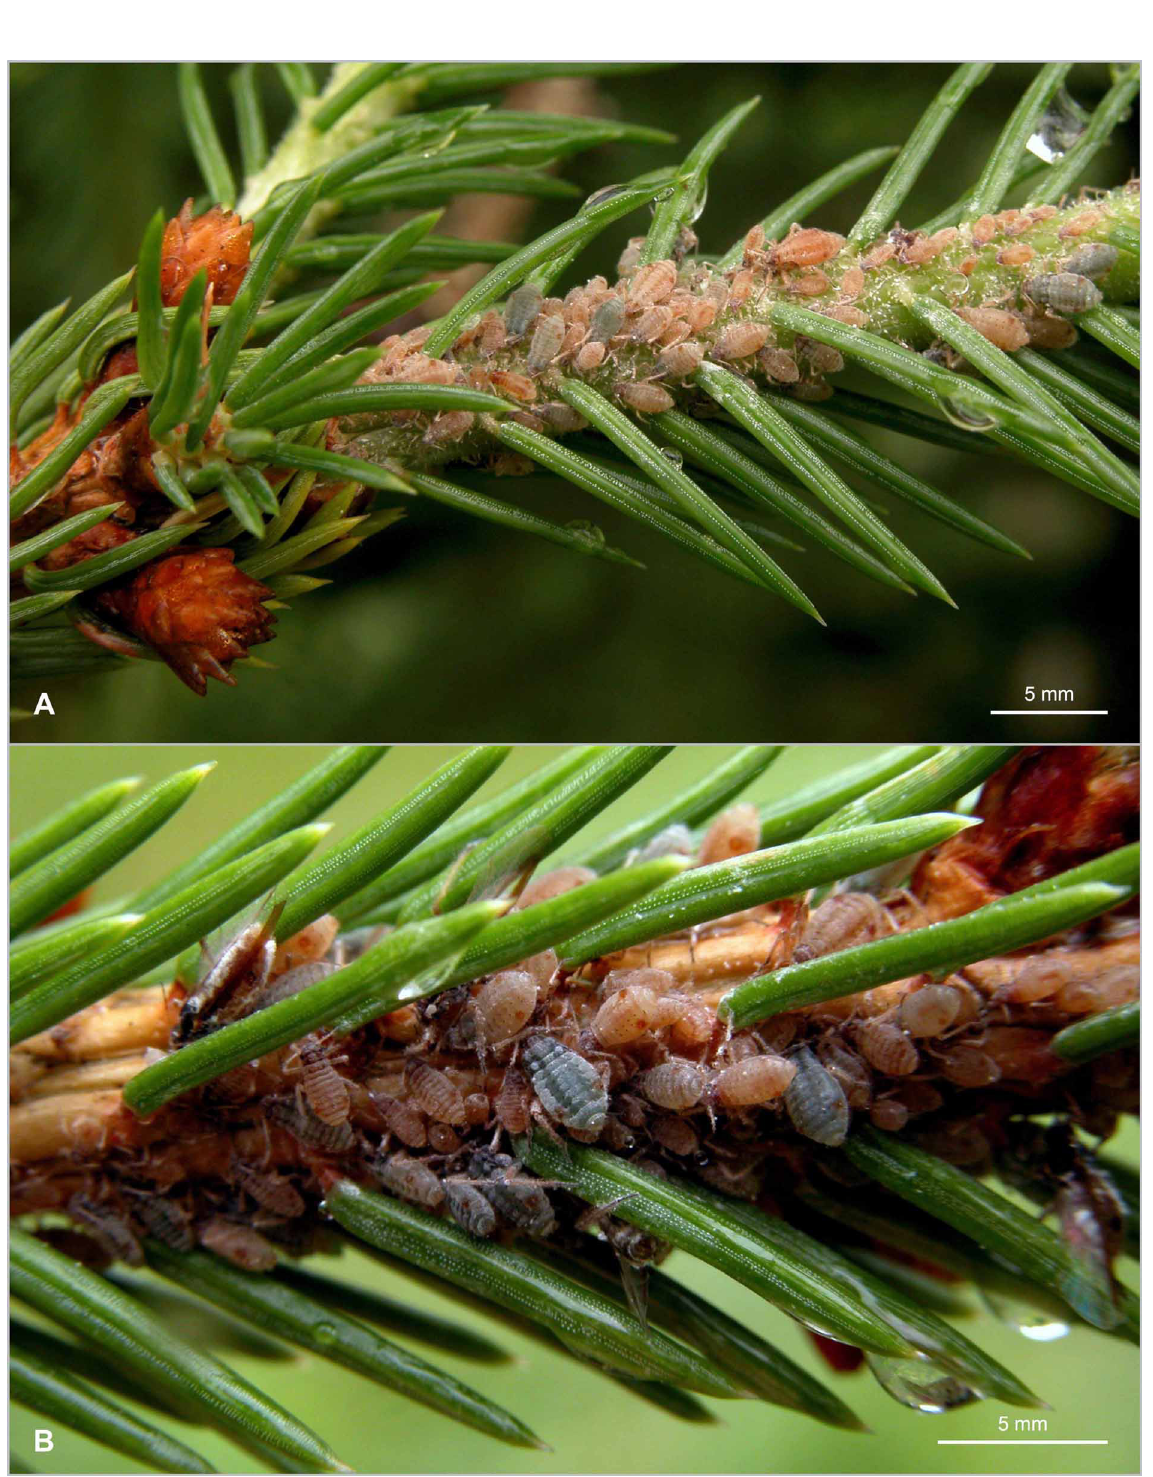
Fig. 30. Cinara (Cinara) pilicornis (Hartig, 1841) on Picea abies . Typical mid-summer colonies on branch